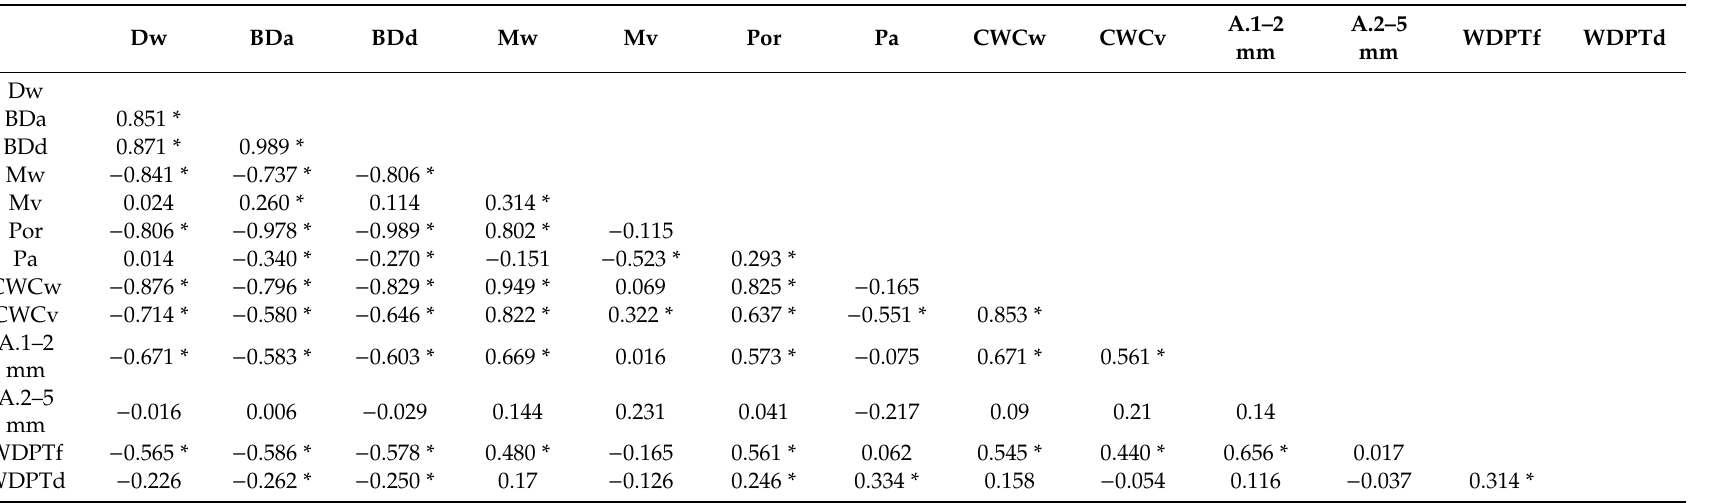
Table 8. The Pearson correlation coe ffi cients between physical